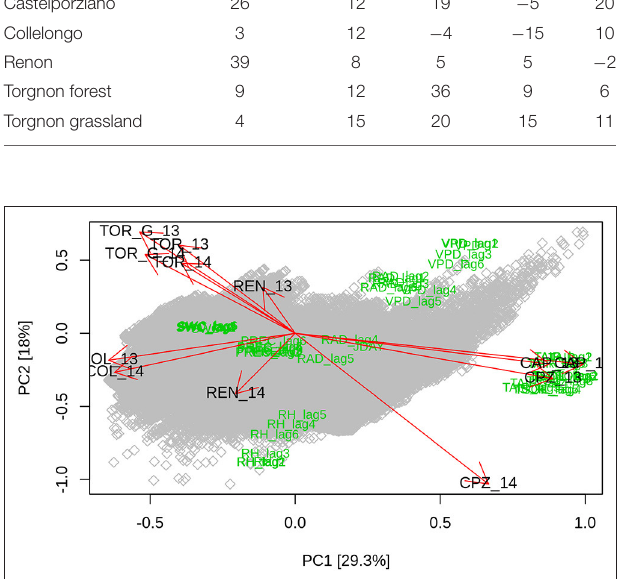
FIGURE 2 | Biplot (arrows indicate average scores for different sites; gray squares are scores; green labels are loadings) of the two principal components showing differences in the position of the investigated sites between the 2 years of study (indicated with”_13” and “_14” for 2013 and 2014, respectively). Variables clustering together indicate similar environmental conditions. Divergence between variables’ position in the biplot indicates different underlying